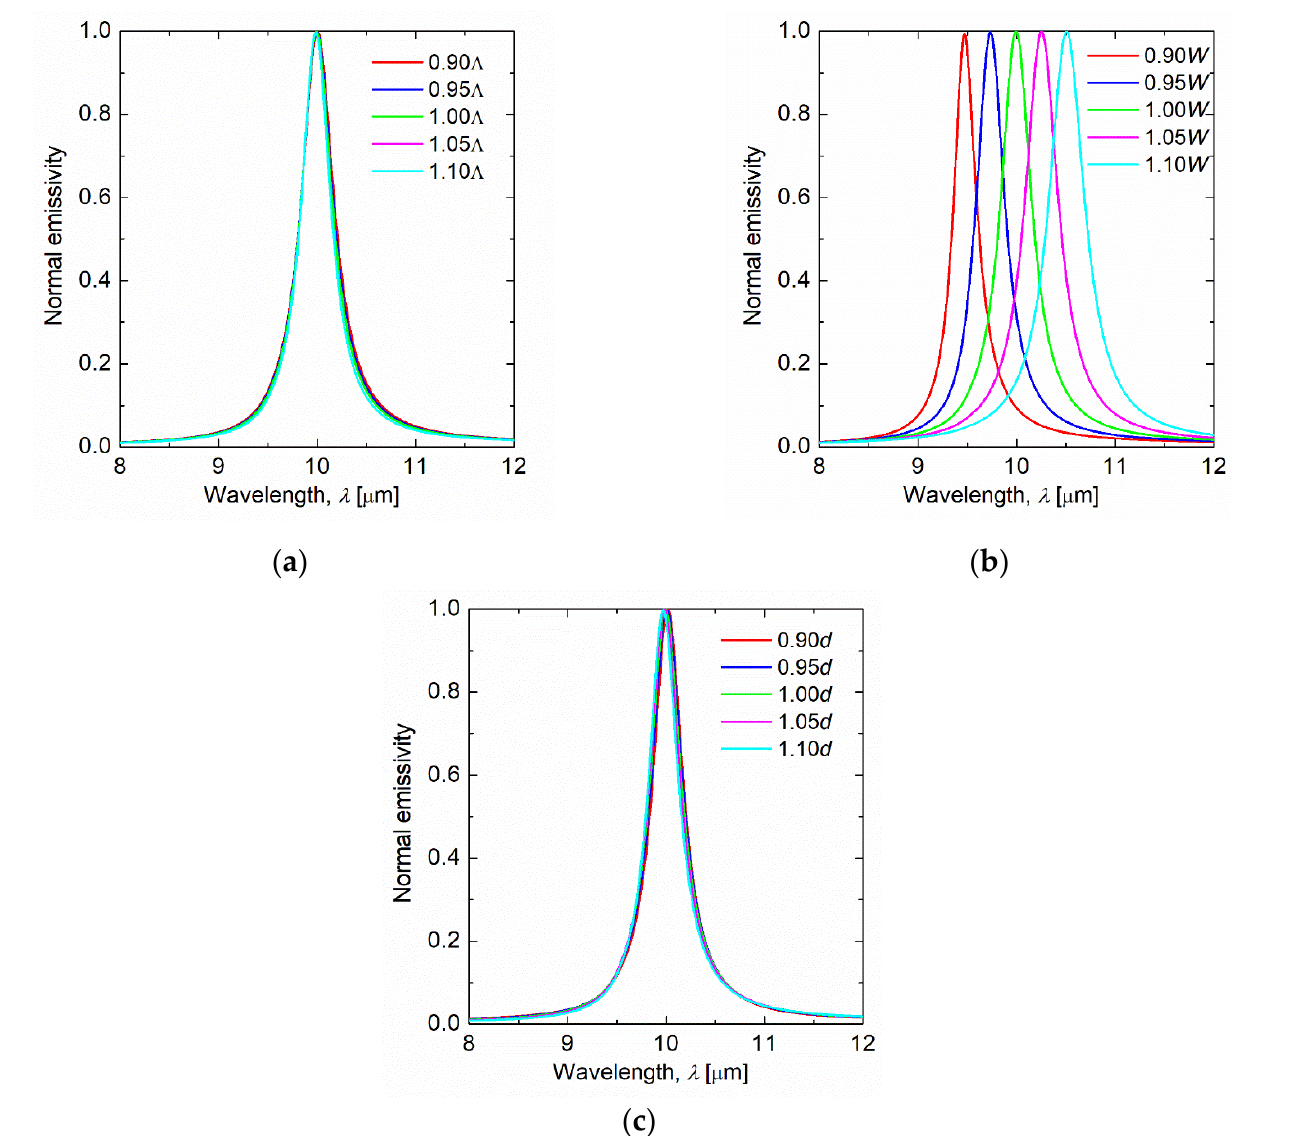
Figure 8. Normal emissivity spectrum for graphene ribbon metasurface with different period, graphene ribbon width, and dielectric thickness. ( a ) The target wavelength is 10 µm, and the period is 0.9–1.1 times of Λ = 5.23 µm. ( b ) The target wavelength is 10 µm, and the graphene ribbon width is 0.9–1.1 times of W = 0.355 µm. ( c ) The target wavelength is 10 µm, and the dielectric thickness is 0.9–1.1 times of d = 1.64 µm.